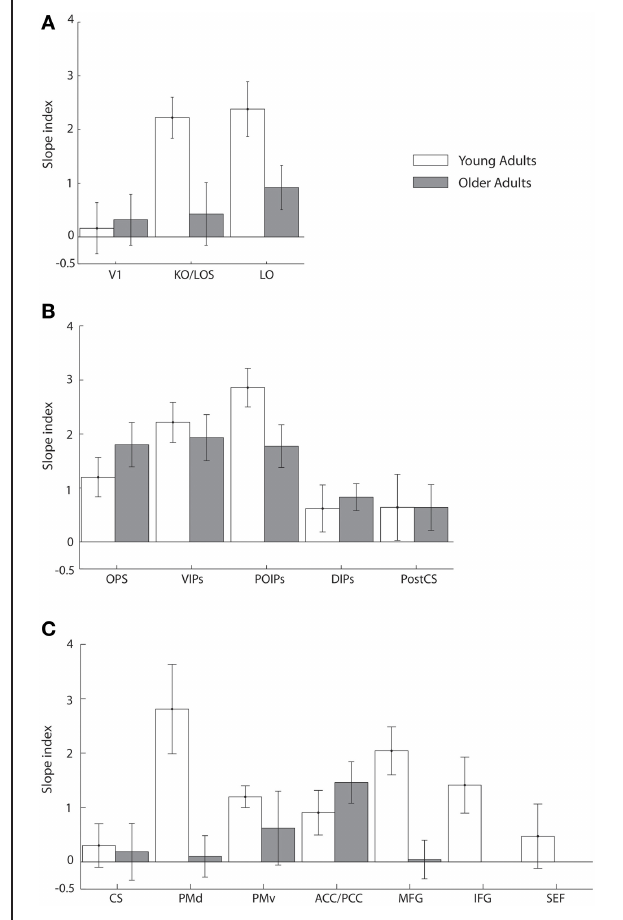
FIGURE 5 | Slope index for fMR-metric functions: main experiment. Slope index (difference in the slope of the fMR-metric functions between pre- and post-training sessions) is plotted for young (white) and older adults (gray) performing the visual discrimination task. ROIs are grouped together by lobe, (A) occipital (B) parietal (C) frontal. Error bars indicate the 95% confidence interval calculated using a bootstrap procedure.